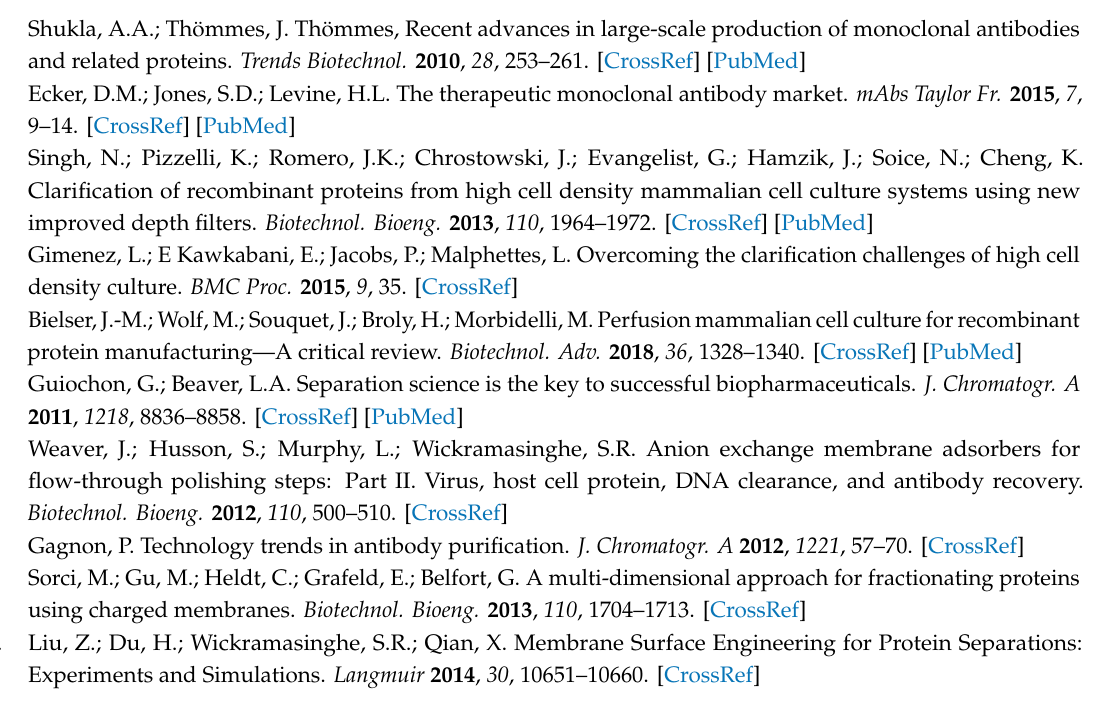
Figure S1: BSA static binding capacities at di ff erent equilibrium times for both surface modified electrospun PSf-GMA-DEA (7 min UV polymerization time) membrane and mPAN-GMA-DEA (15 min UV polymerization time) membrane. For both membranes, four pieces of membranes were soaked in 4 beakers separately containing 3 mg / mL BSA in 20 mM Tris bu ff er at pH 7.0. The equilibration process was conducted at room temperature under gentle shaking. Protein binding capacities were measured after 1, 5, 12, 20 h of equilibration from 4 beakers